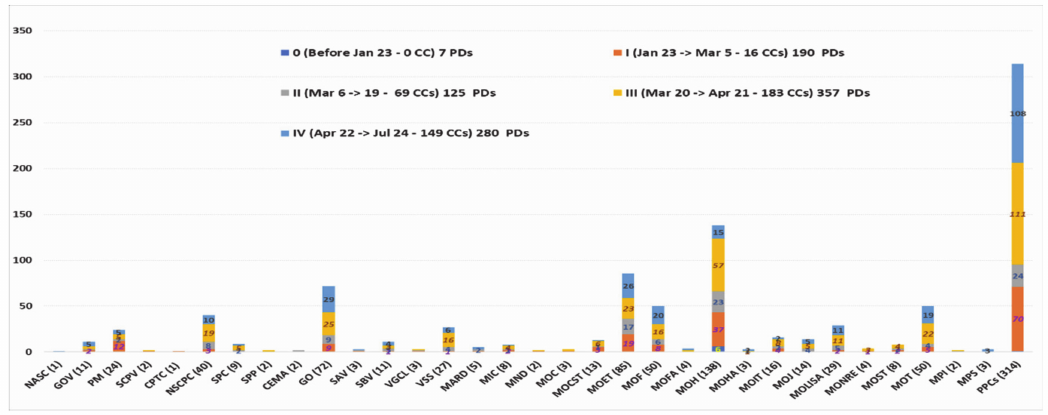
Figure 5. 959 COVID-19 PDs classified by government agencies (as of 24 July